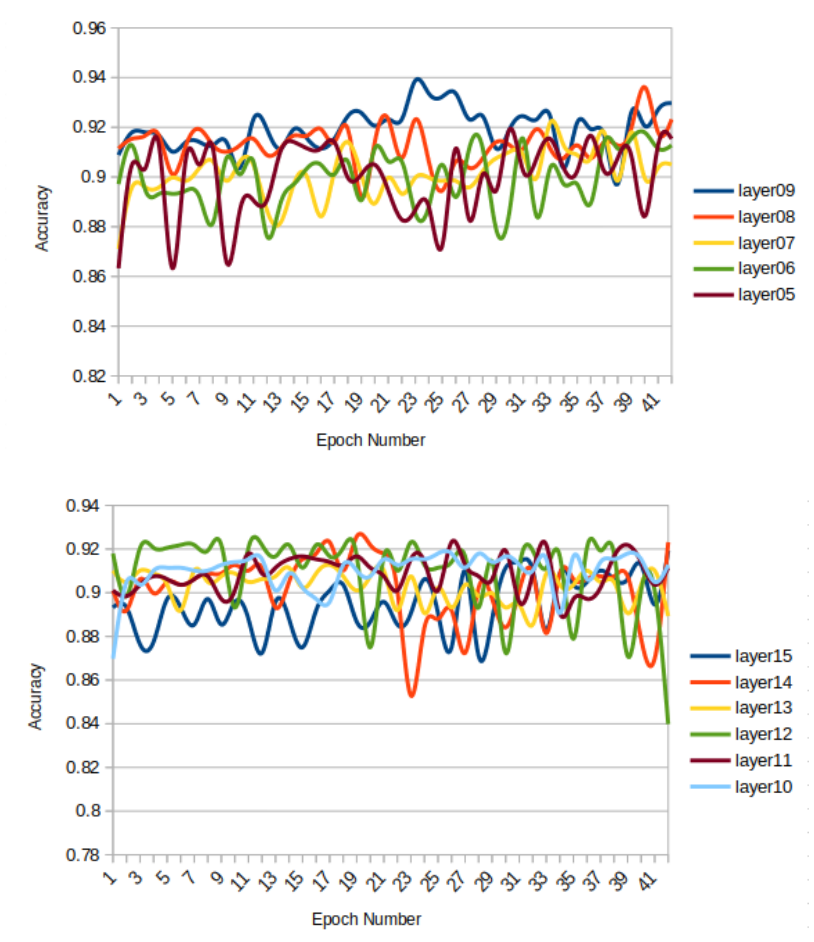
Figure 8. Accuracy during the training of models while utilizing features from different layers of the VGG-16 Network is shown. We have included training data from 60th epoch and upwards. Hence, the 1st epoch in the graph corresponds to the 60th epoch and so on. Empirically, transfer learning of features up to Layer 9 provides the most accurate